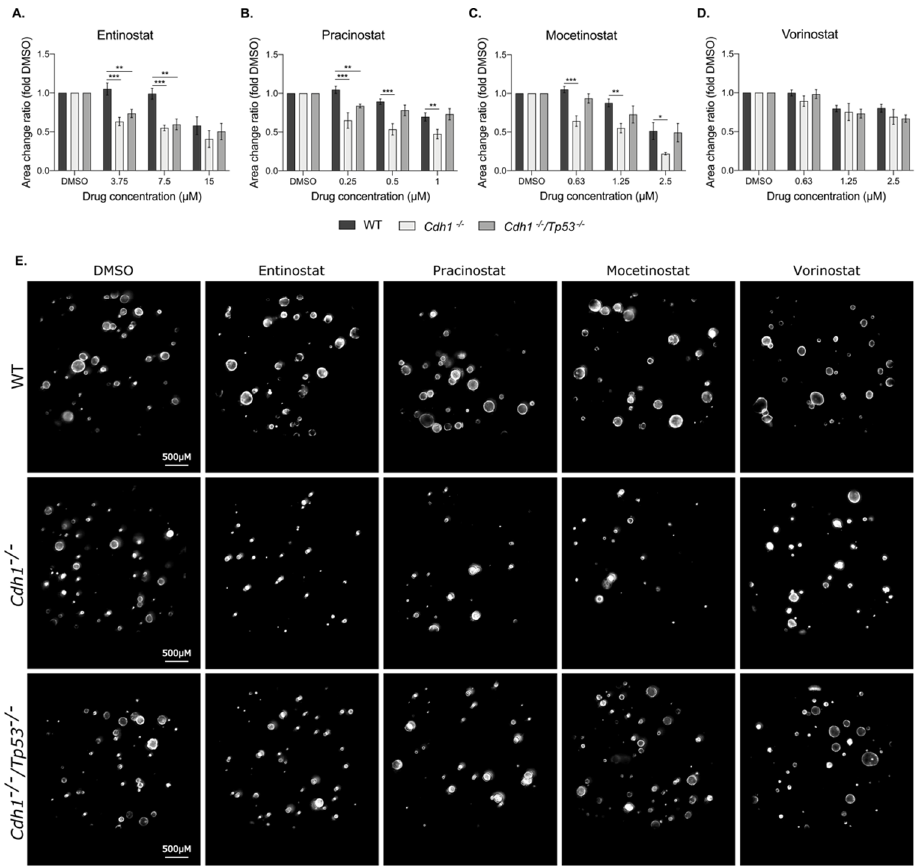
Figure 5. E-cadherin-deficient gastric organoids are more sensitive to pan-HDAC inhibitors. WT, Cdh1 − / − and Cdh1 − / − / Tp53 − / − organoids were drugged for 48 h with the different pan-HDAC inhibitors, and the area of the organoids was then measured and normalized to their respective vehicle controls. RFP fluorescence was used to detect tdTomato and determine the area of the organoids, using Cytation 5 imager (Biotek, Winooski, VT, USA). ( A ) Entinostat induced a synthetic lethal effect with a maximum of 44% differences between WT organoids and Cdh1 − / − ones and 40% for the Cdh1 − / − / Tp53 − / − organoids. ( B ) Pracinostat induced an SL effect up to 40% and 20% for the Cdh1 − / − and the Cdh1 − / − / Tp53 − / − organoids respectively. ( C ) Mocetinostat preferentially targeted E-cadherin-deficient cells with a maximum of 39% decrease in Cdh1 − / − area compared to WT ones and had no effect for Cdh1 − / − / Tp53 − / − organoids. ( D ) Vorinostat did not present any significant synthetic lethal effect between the WT and the E-cadherin-deficient gastric organoids. n = 3–5 per compound. All the IC50 are summarized in Table S5. Statistically significant results are labeled as * p < 0.05, ** p < 0.01 and *** p < 0.001. ( E ) Picture representation of WT, Cdh1 − / − and Cdh1 − / − / Trp53 − / − organoids after 7.5 µ M entinostat, 0.25 µ M pracinostat, 0.63 µ M mocetinostat and 0.63 µ M